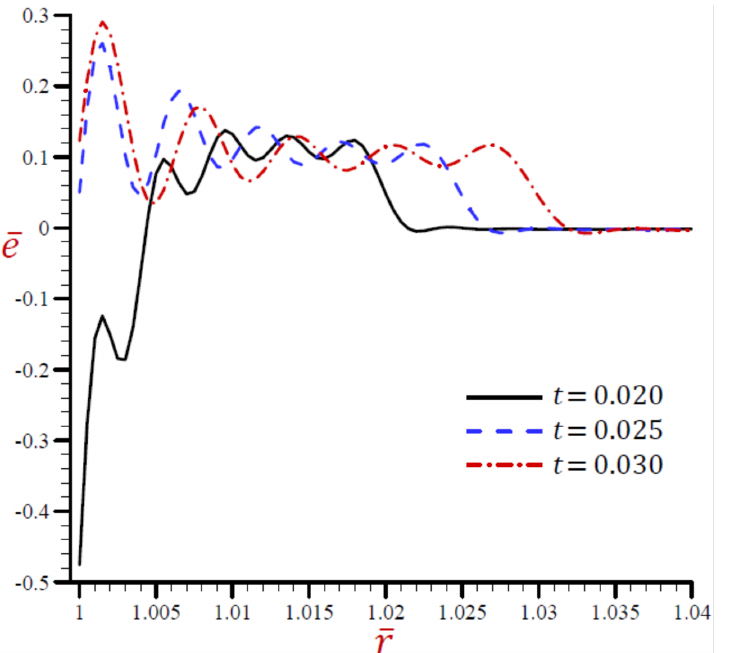
Figure 20. Effect of t on dilatation e across the radial direction of the cylindrical cavity utilizing the RDPL model.